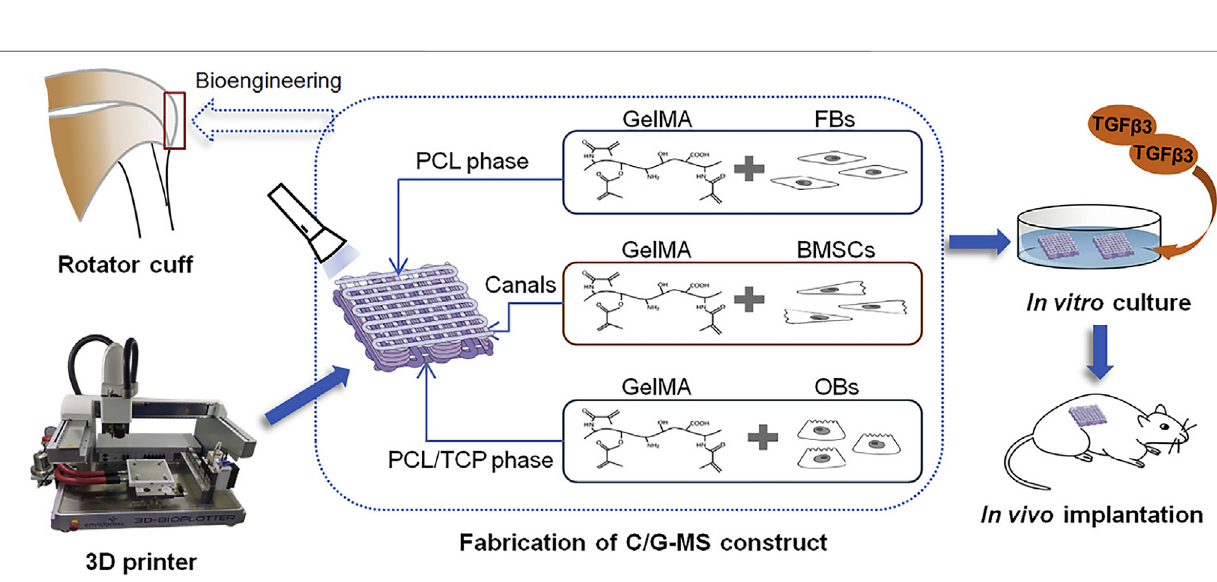
( Figure 5 ) (Chen et al., 2020). The self-healing property of this hydrogel ensured the safety of application in the RCT